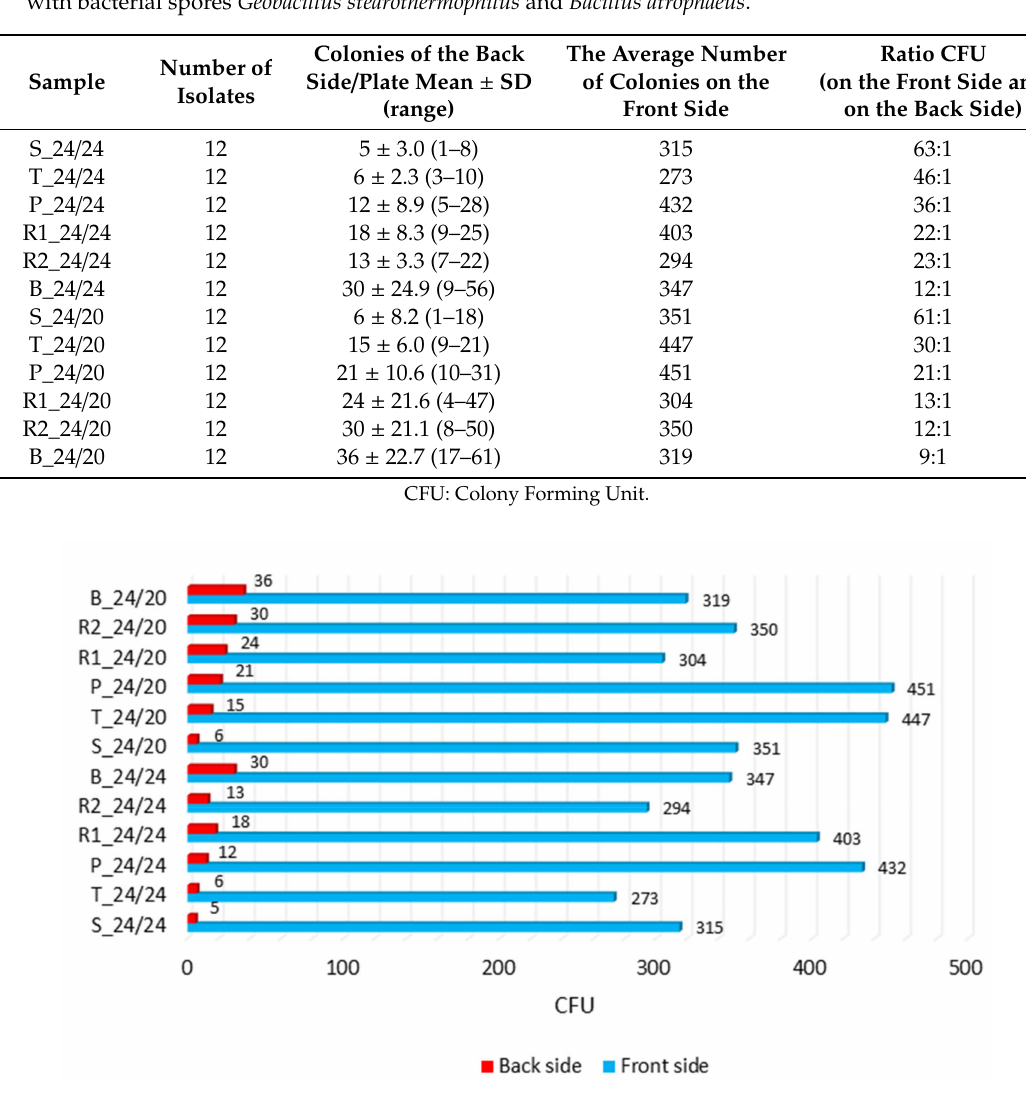
Figure 7. Results of microbial barrier permeability (after 24 h): The average number of bacterial colonies (CFU) on the front side and the back